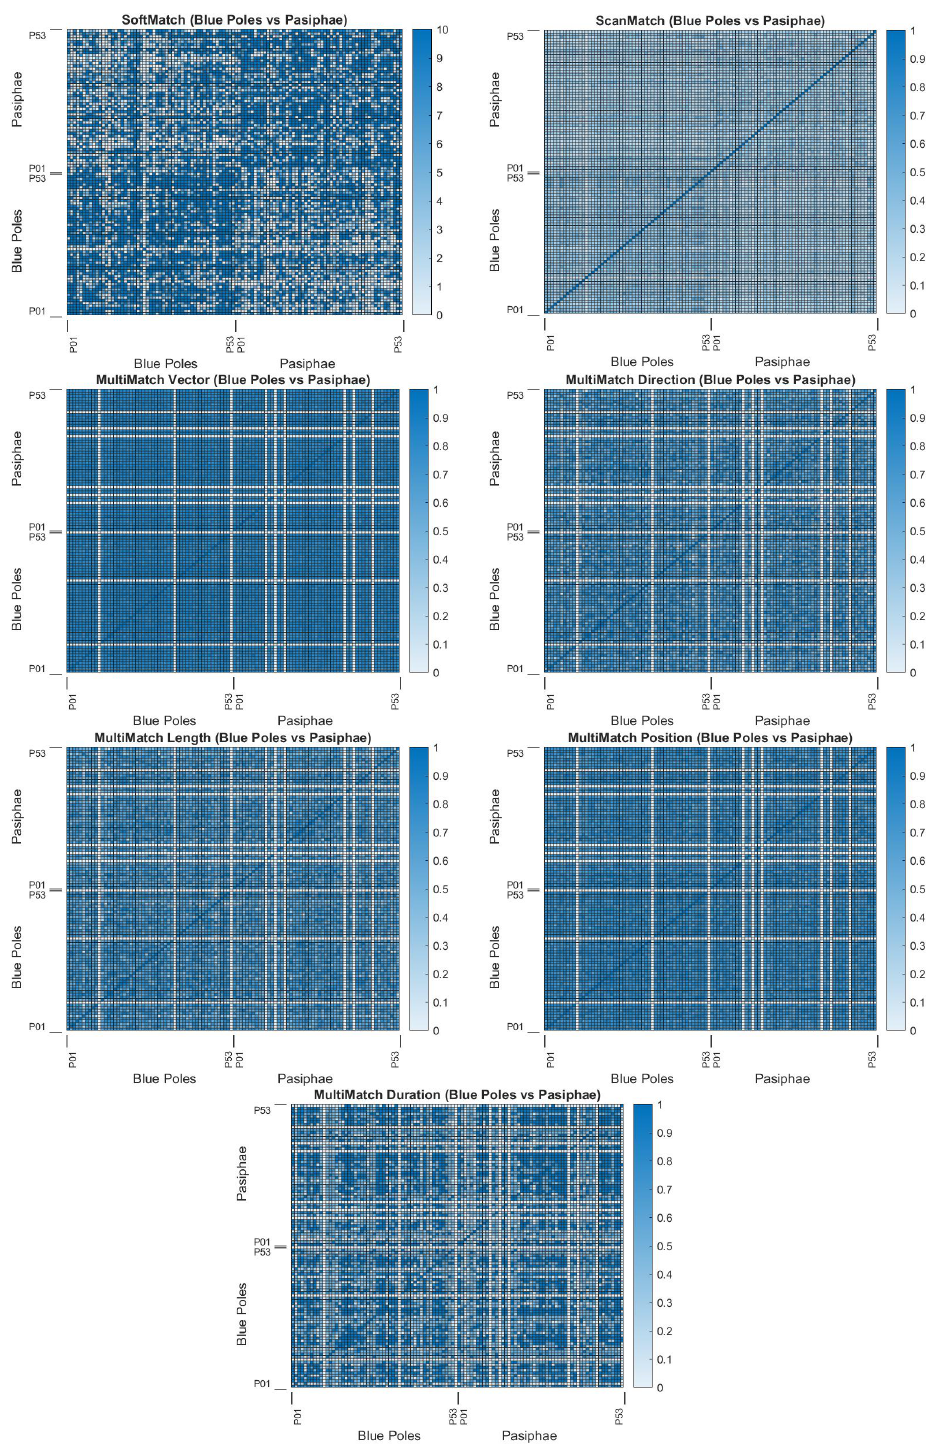
Figure A3. SoftMatch, ScanMatch, and MultiMatch heatmaps for empirical evaluation. Stimuli matched are Jackson Pollock’s Blue Poles (1952) and Jackson Pollock’s Pasiphae